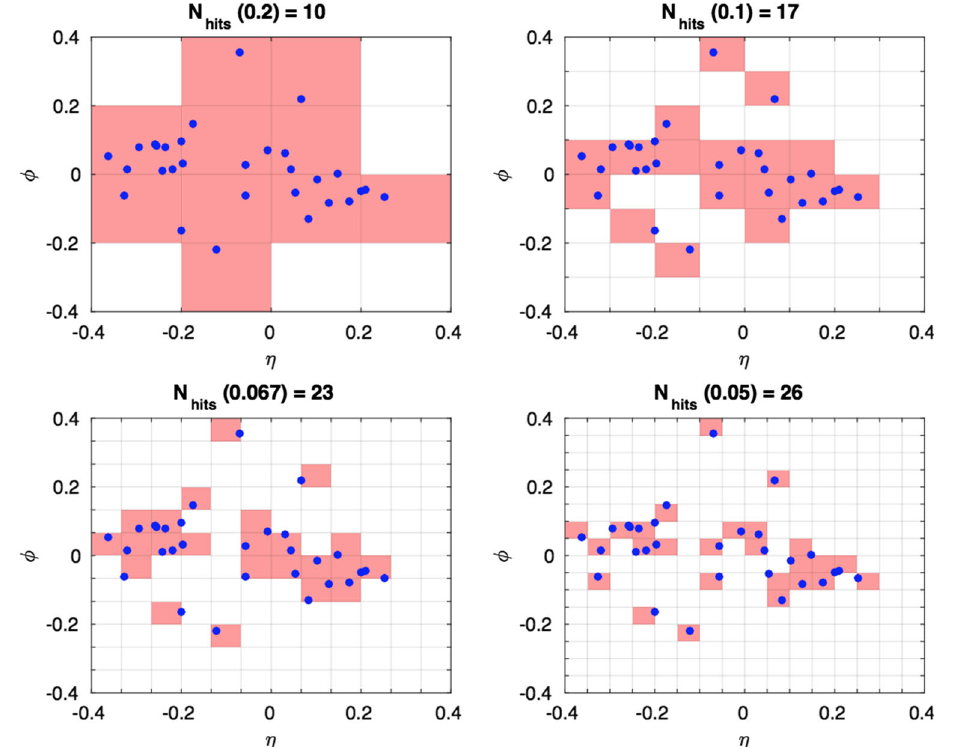
Fig. 1 An illustration of the iterated box-counting procedure used to calculate fractal-based quantities on a set of points. The filled blue cir- cles are the (η,φ) angular coordinates of the hadrons within a particular sample jet (in particular, this jet has total p T = 157 GeV, and 30 con-